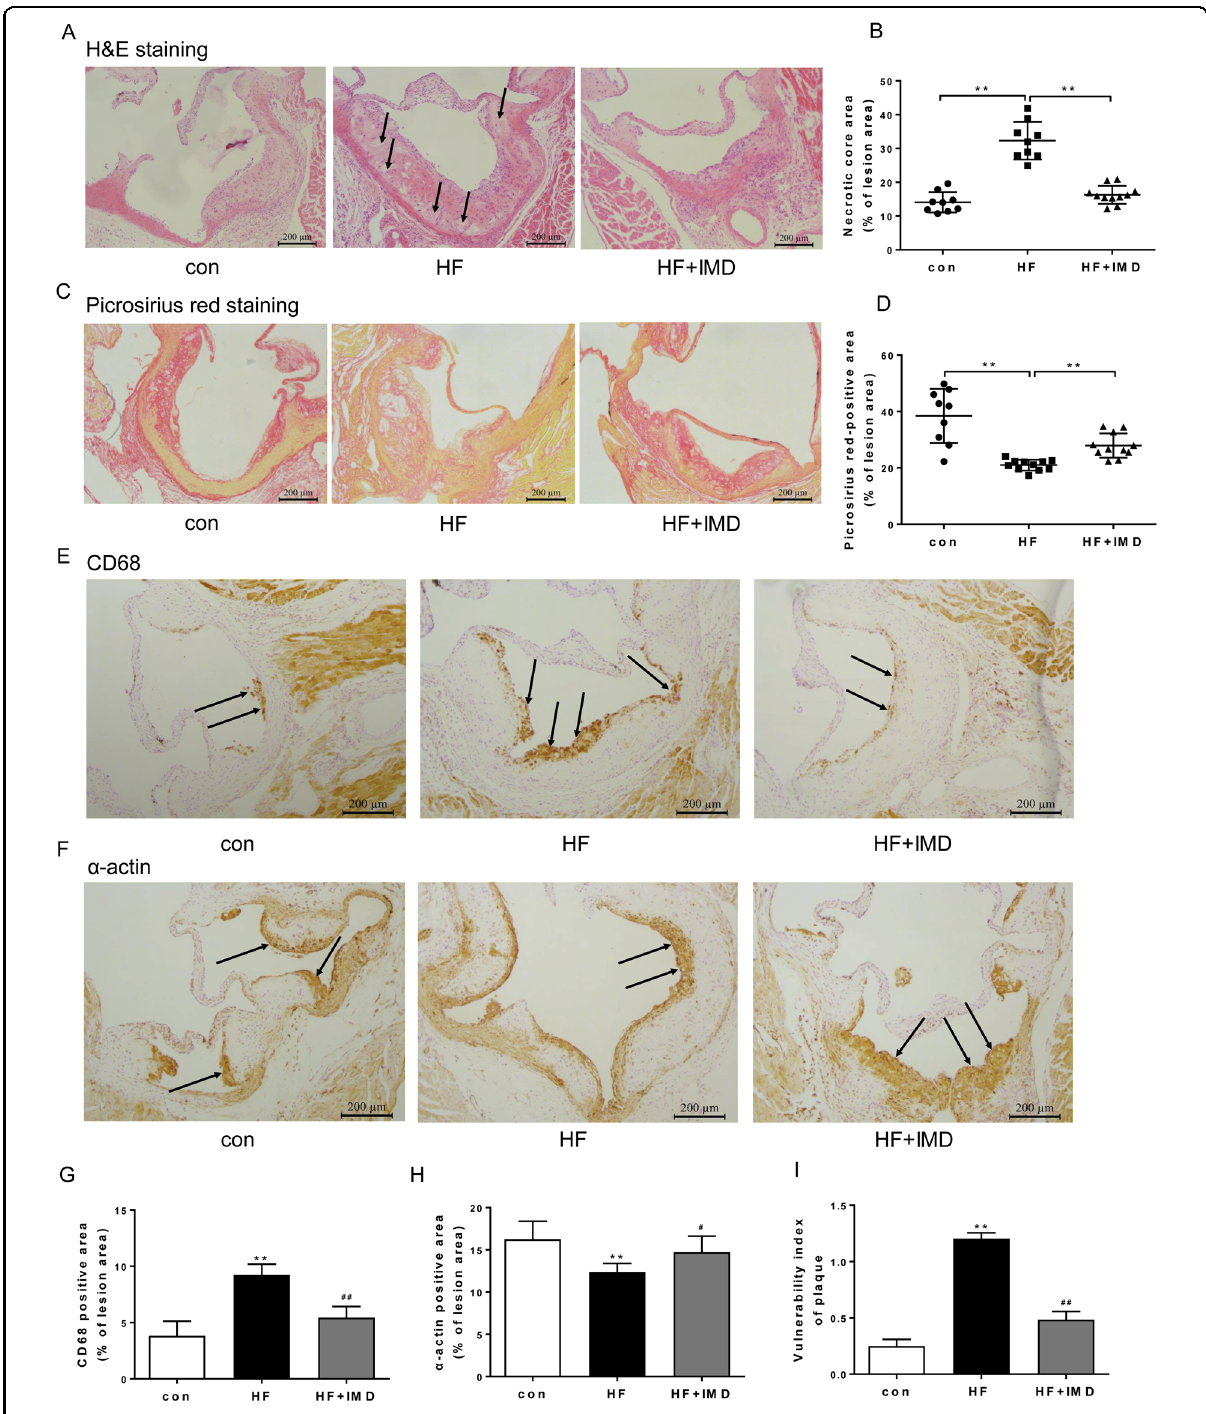
Fig. 2 IMD 1-53 promoted atherosclerotic plaque stability at the aortic root of ApoE − / − mice. Eight-week-old male ApoE − / − were fed a standard chow diet (con) or a high-fat diet (HFD) for 16 weeks. After 10 weeks of HFD feeding, ApoE − / − mice received either PBS or intermedin 1-53 (IMD 1-53 ) during the left 6 weeks of high-fat diet feeding. A , B Necrotic core area at the aortic root was measured. Representative H&E-stained sections ( A ) from each group are displayed next to the quanti fi cation data ( B ). Black arrows indicate the necrotic core. Scale bars, 200 μ m. C , D Collagen area at the aortic root was measured. Representative picrosirius red-stained sections ( C ) from each group are displayed next to the quanti fi cation data ( D ). Scale bars, 200 μ m. n = 9 – 11. Data are mean±SD. * P <0.05, ** P <0.01 ; one-way ANOVA. E – H Representative images of CD68 ( E ) and α -SMA ( F ) immunohistochemical staining and quantitative analysis of macrophage ( G ) and vascular smooth muscle cell (VSMC) ( H ) contents at the aortic root of mice from each group. Black arrows indicate cells stained positively for CD68 or α -SMA. Scale bars, 200 μ m. I Quantitative analysis of plaque vulnerability index at the aortic root of mice from each group. n = 6. Data are mean±SD. ** P <0.01 compared with con, # P <0.05, ## P <0.01 compared with HF group; one-way